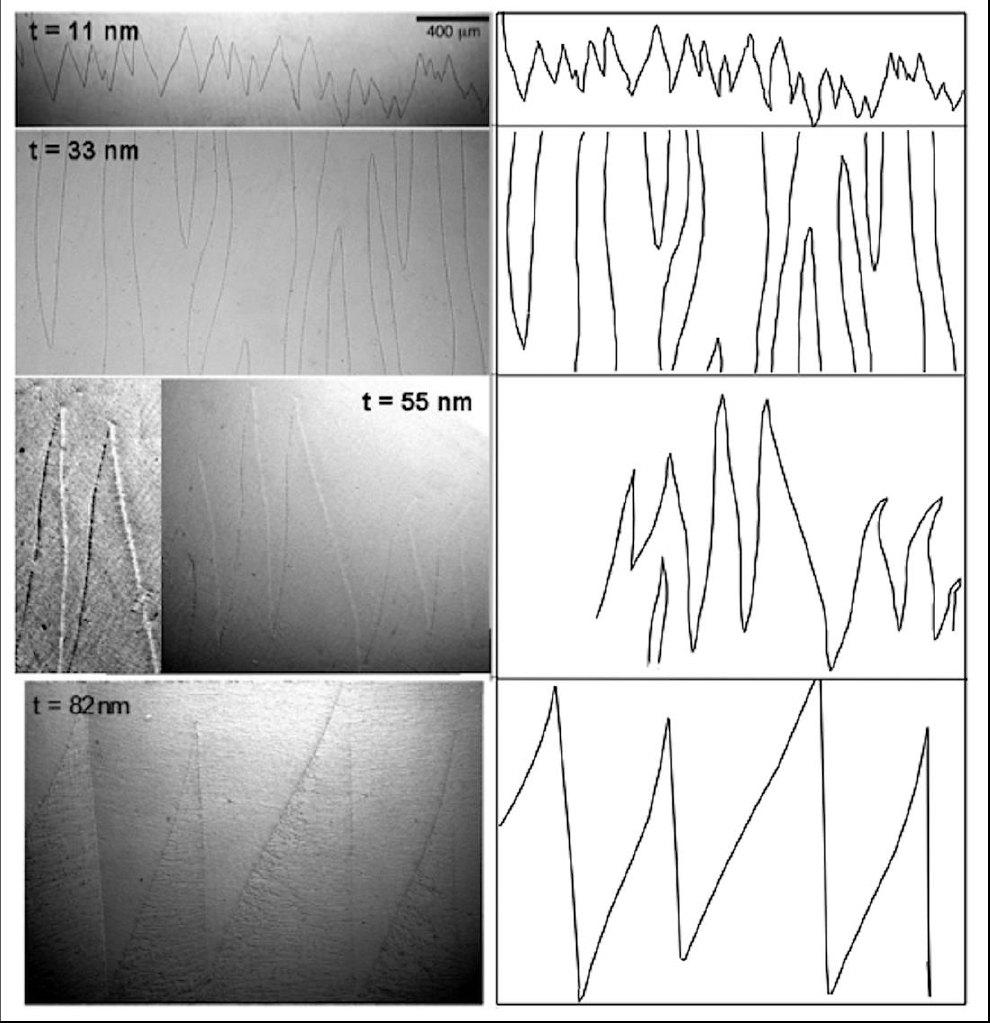
Figure 5. ( Left ): Bitter patterns of Fe films with different thicknesses t : charged zigzag walls are shown. Images were obtained while demagnetizing the films and were digitally cleaned and enhanced; additional image was superimposed on the left of the 55 nm film. ( Right ): Illustration of walls. Depending on sample thickness, charged walls exhibit different characteristic vertex angle, shape, lengths of segments of zigzag walls, and core type (see text for explanation).